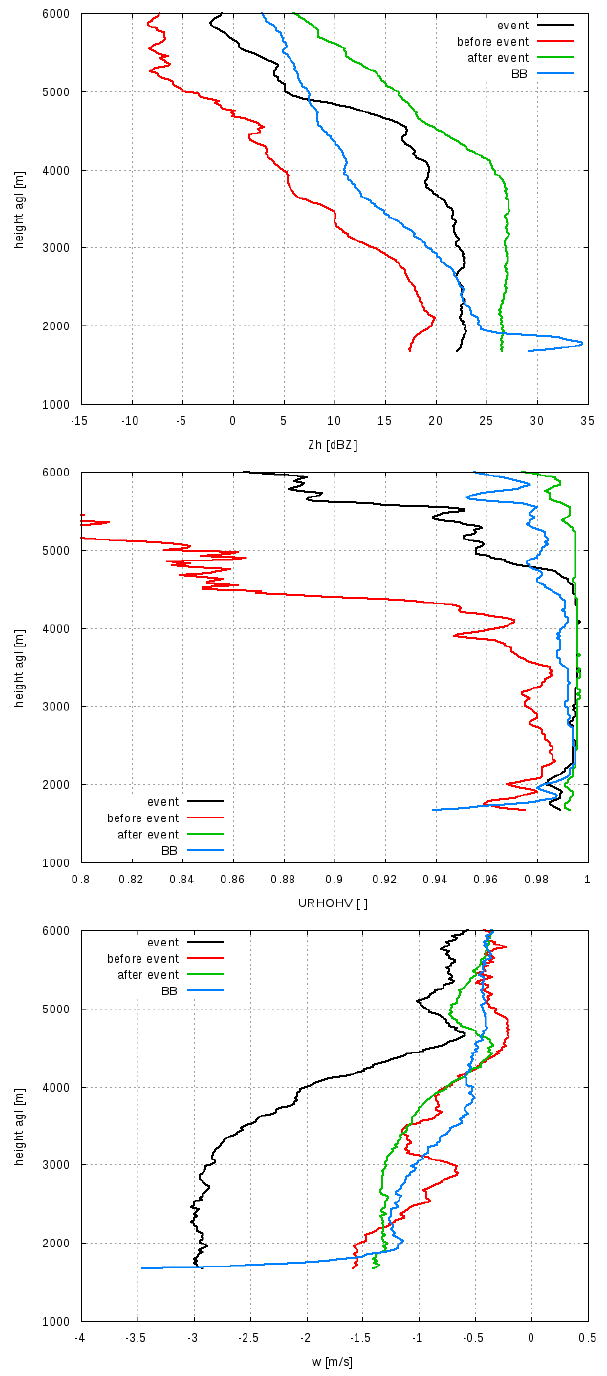
Figure 8. Time-averaged profiles of UZ h (upper panel), ρ hv (mid- dle panel) and fall velocity (lower panel) for specific time inter- vals: before the event (10:00–11:00UTC), the event itself (11:10– 11:40UTC), and after the event (13:00–14:00UTC). In addition we show a mean profile of when the bright band is clearly visible (00:00–00:50UTC).